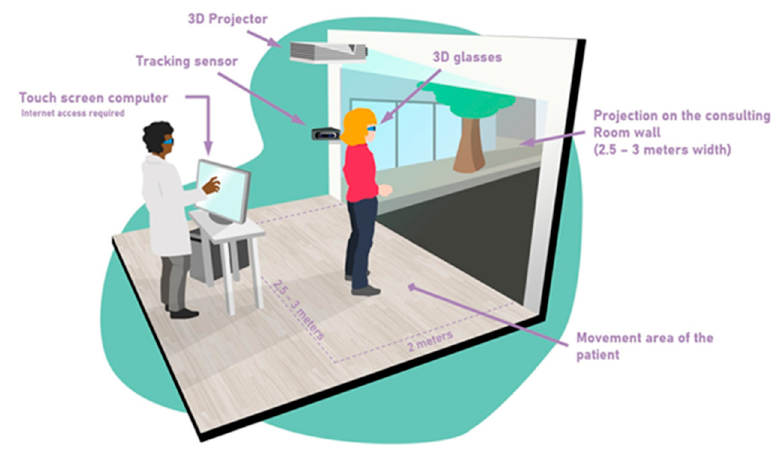
Figure 1. Experimental setup of MoveR training.